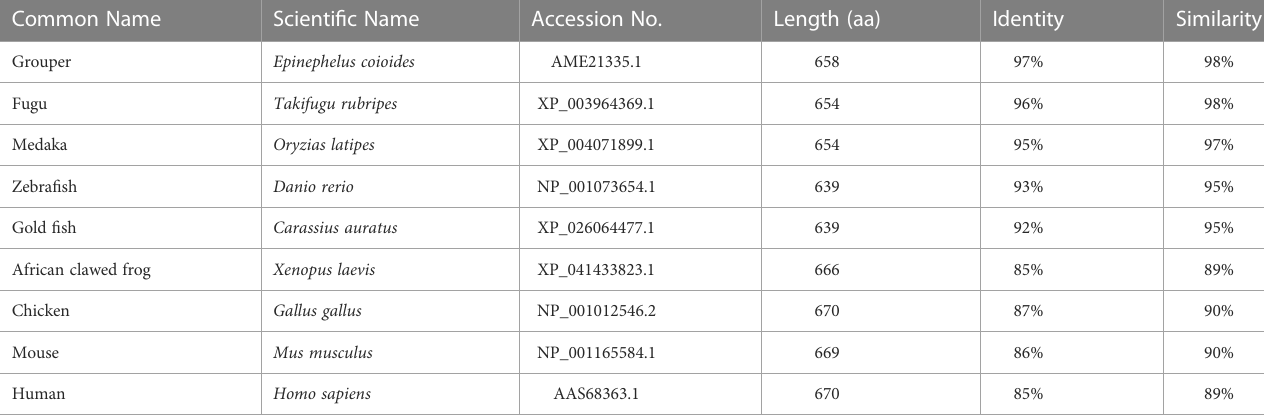
TABLE 2 Amino acid identity and similarity among Lc -TRAF7 and TRAF7 from other